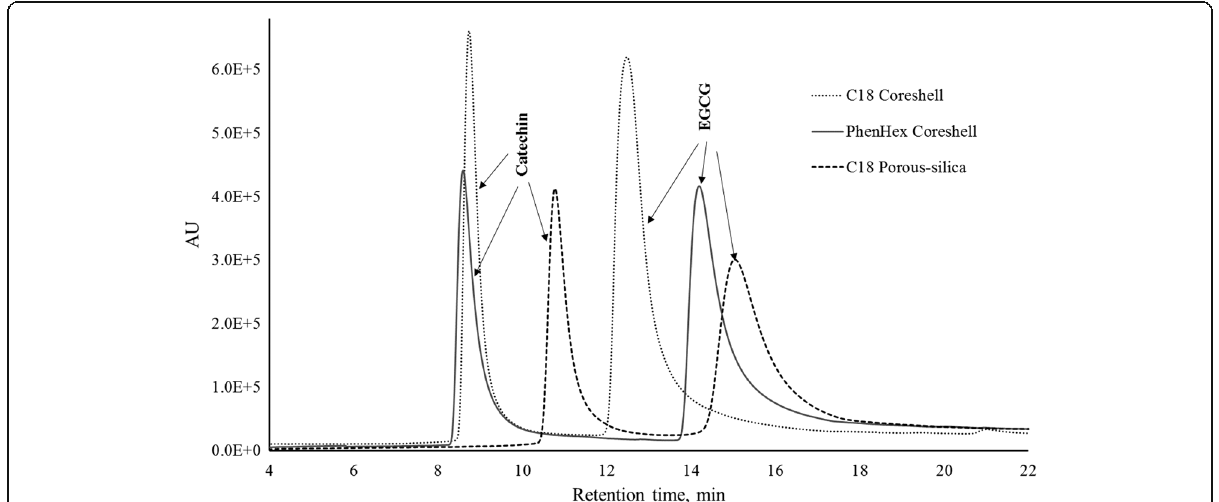
Fig. 1 Comparative chromatograms of standard antioxidants with CUPRAC post-column derivatization reagent using porous silica and core-shell column stationary phases